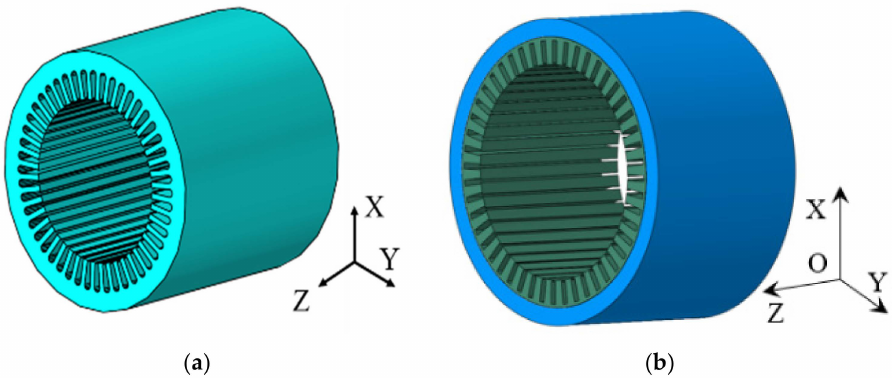
Figure 1. Equivalent finite element model of stator core and stator system. ( a ) stator core; ( b ) stator system.